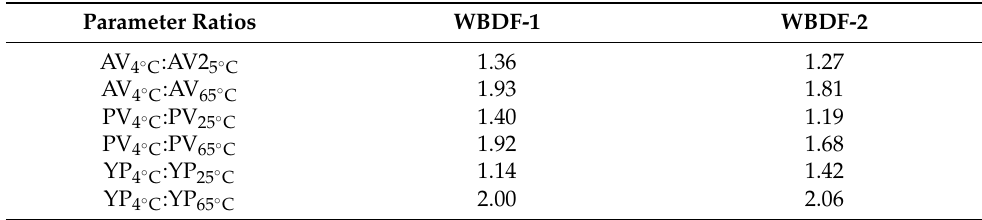
Table 3. Parameter ratios for different drilling fluid systems. Parameter Ratios